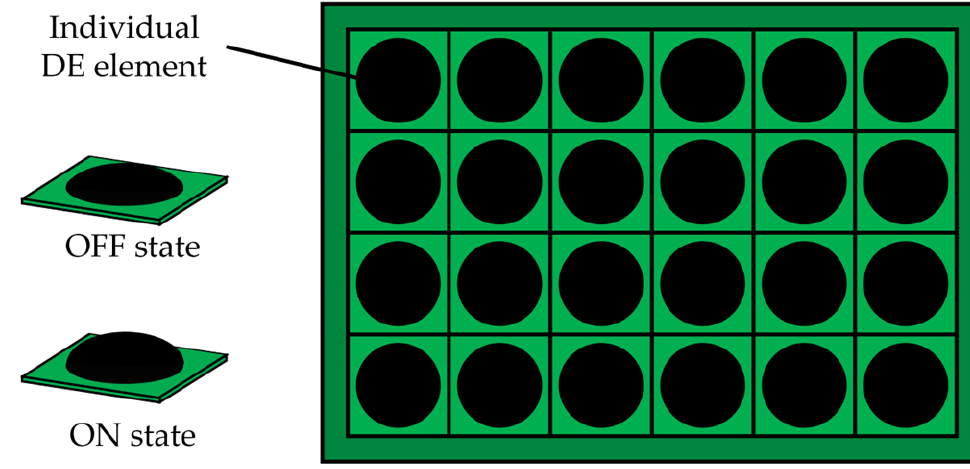
Figure 5. A prototypical example of cooperative DE actuator/sensor system.